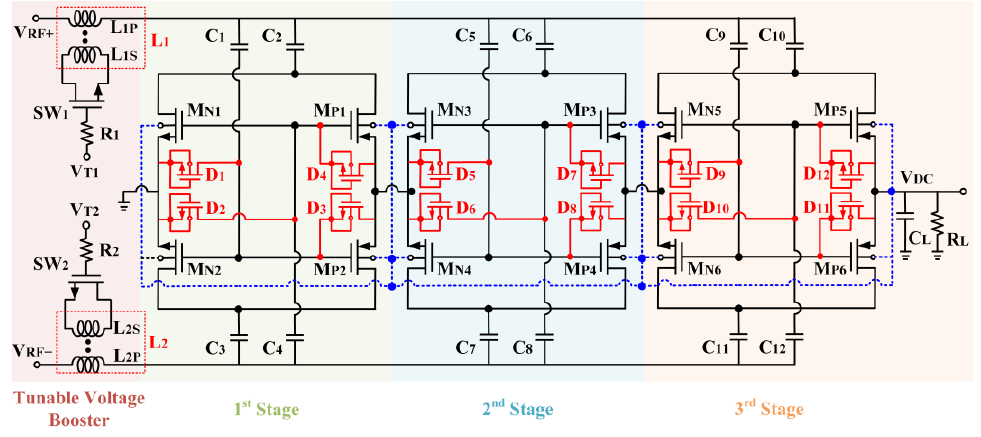
Figure 12. Detailed schematic of the CCDD-TVB rectifier.